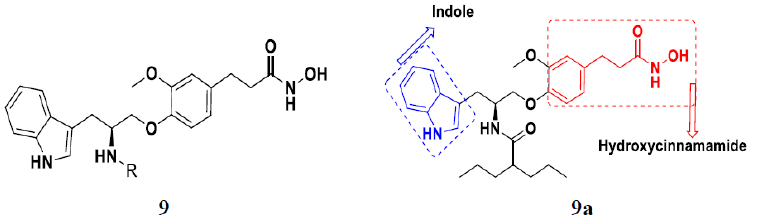
Figure 11. Structure of indole with hydroxycinnamamide hybrid and the most promising com- pound 9a. Table 9. In vitro cytotoxicity (IC 50 ) of hybrid compounds 9 ( b – e